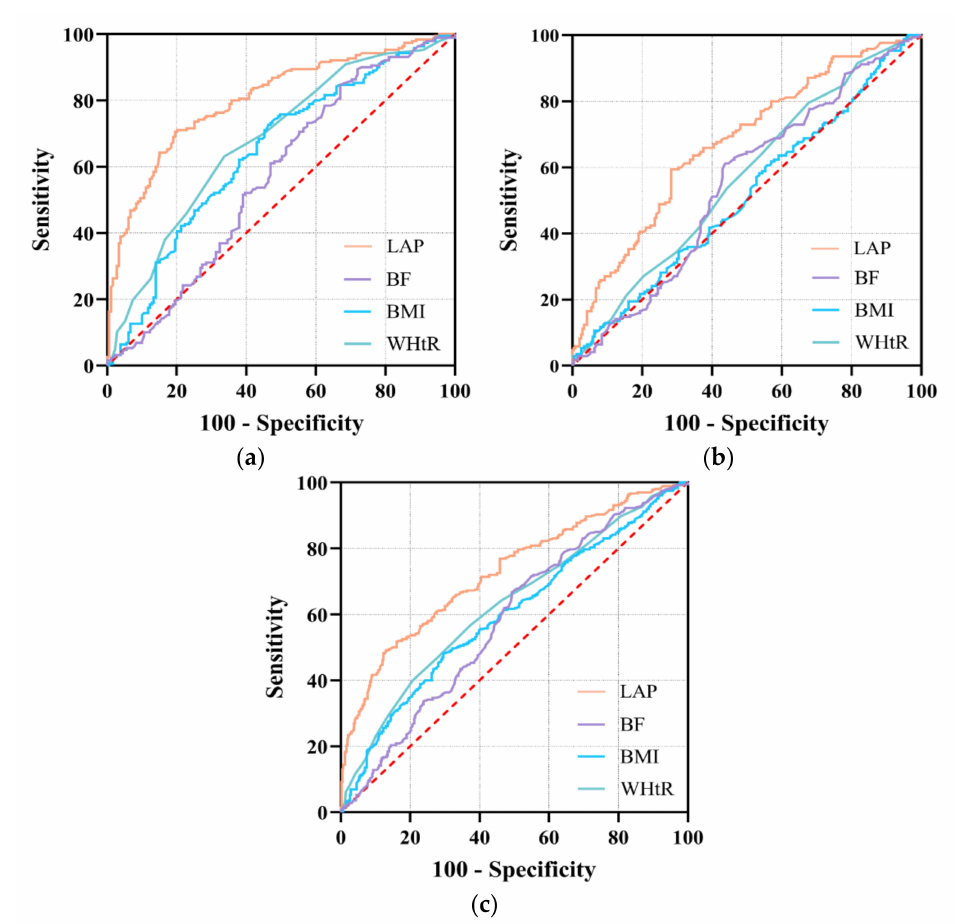
Figure 1. ROC curve of LAP, BF, BMI and WHtR for predicting dyslipidemia. ( a ): male; ( b ):